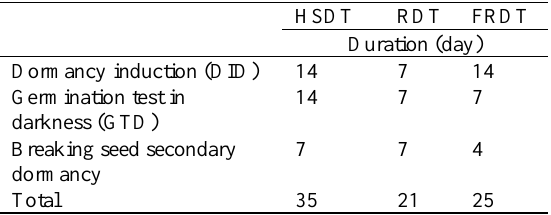
Table 3. Time comparison of the three stages used in the different methods for assessing the seed secondary dormancy in